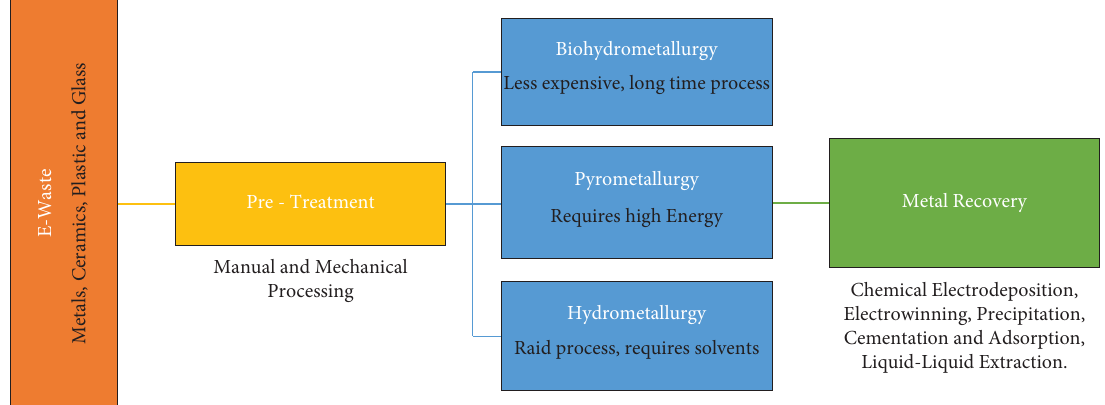
Figure 1: Diagram of metal recovery from e-waste from industrial water. In terms of pretreatment, there are two types: manual processing, which involves sorting, separating, cleaning, emptying, dismantling, decontaminating, and segregating, and mechanical processing, which involves shredding, milling, grinding, and separating through eddy current or air stream classifers.